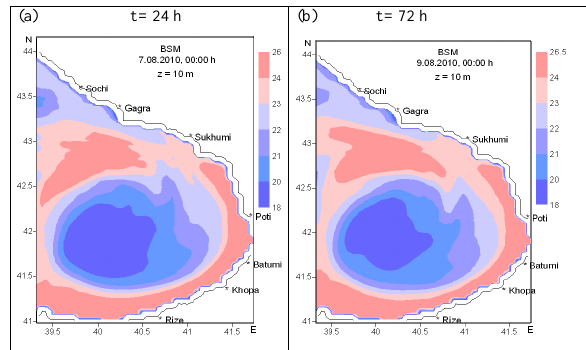
Fig. 7. The temperature fields (deg. C) on depth of 10 m predicted by RM-IG at 24 h and (b) 72 h (the forecasting period is 6.08.2010, 00:00 h –9.08.2010, 00:00 h).